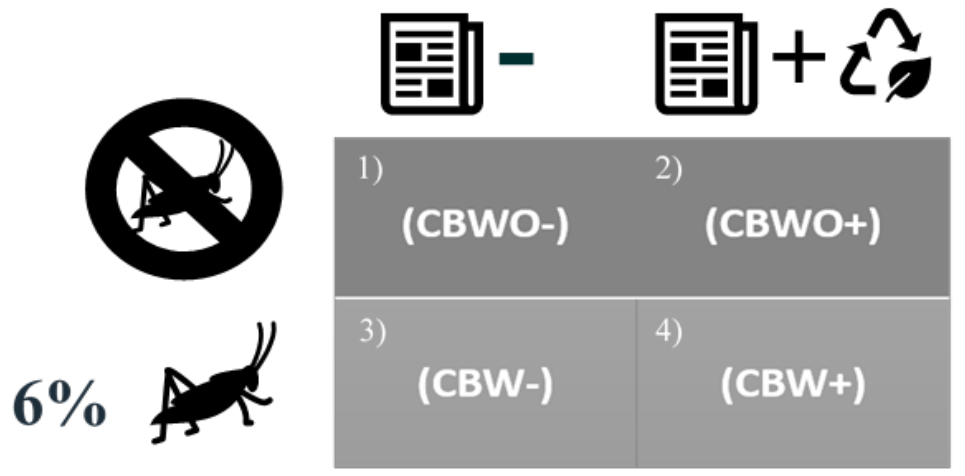
Figure 1. Treatments presented under informed conditions. ECP: Edible-cricket protein. CB: Choco- late brownies. WO: Without; W: With. ECP − : “No ECP” informed condition. ECP+: “Contains ECP + benefits” informed condition. (1) CBWO − : chocolate brownies without ECP (CBWO) presented under the ECP − informed condition; (2) CBWO+: CBWO presented under the ECP+ informed condition; (3) CBW − : chocolate brownies with 6% ECP (CBW) presented under the ECP − informed condition; (4) CBW+: CBW presented under the ECP+ informed condition.